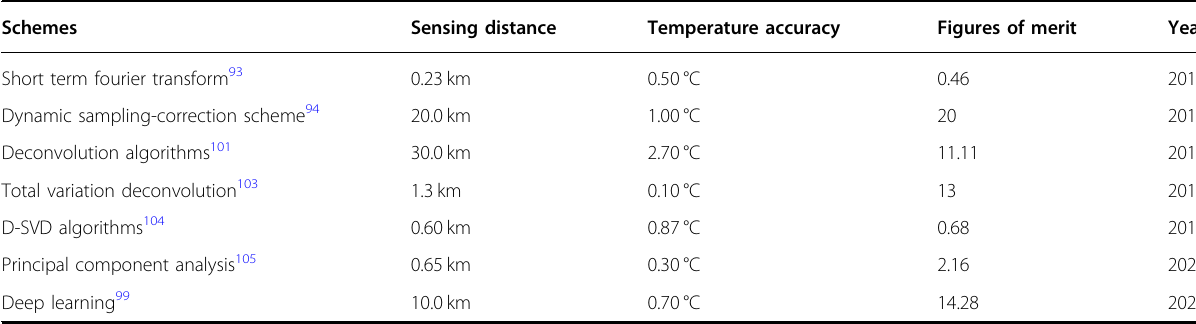
Table 4 Typical algorithm denoising schemes and